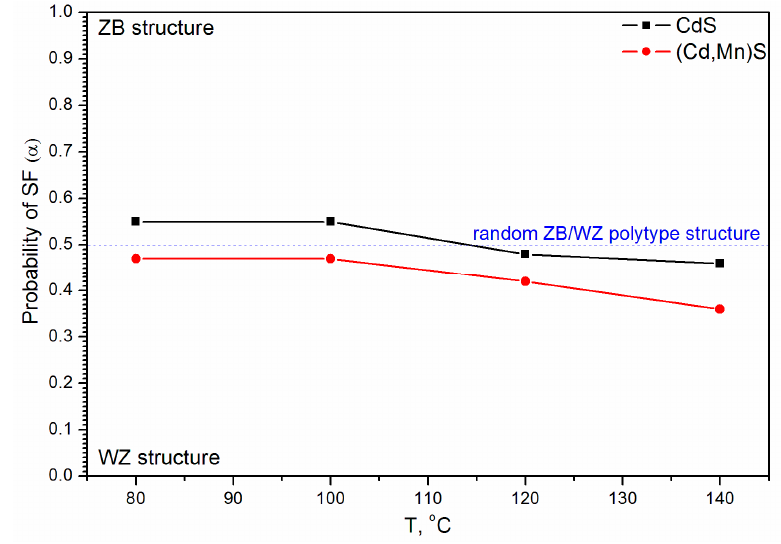
Figure 7. Dependence of probability of SFs in WZ structure ( α ) on temperature T.